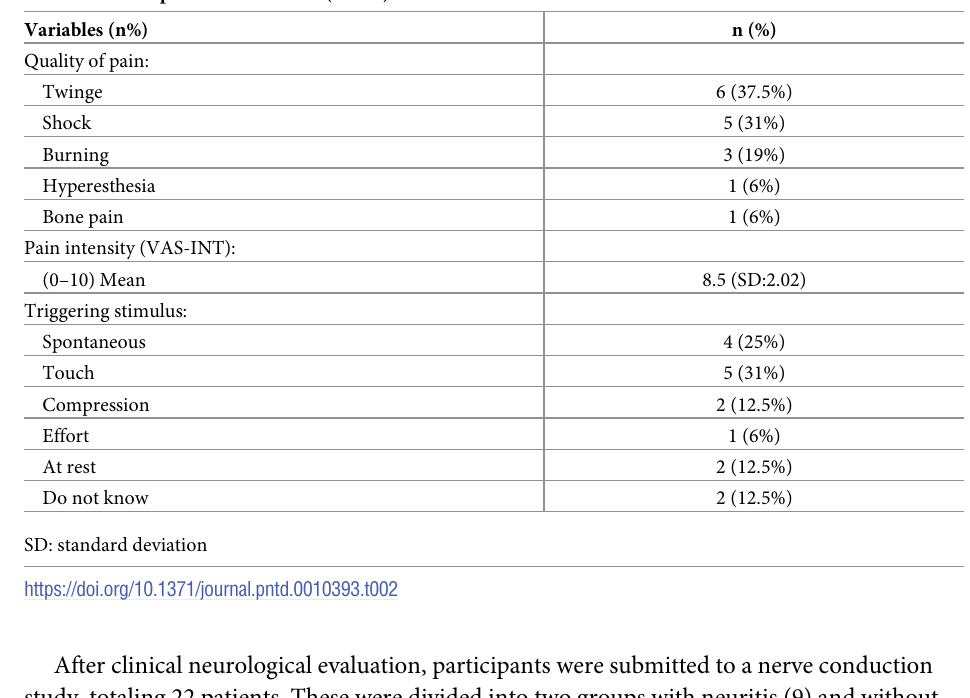
Table 2. Neural pain characteristics (n = 16).